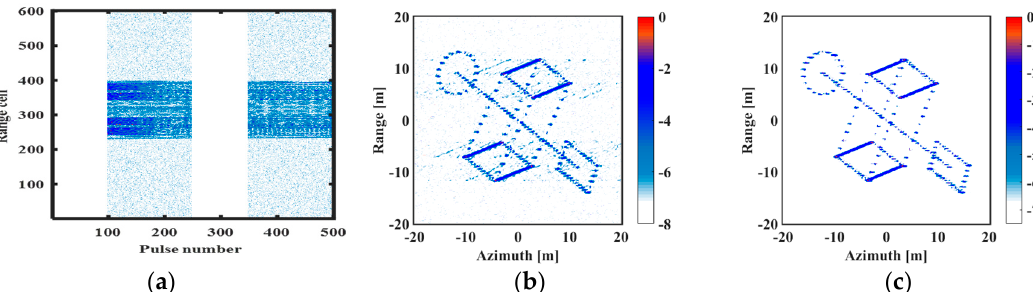
Figure 8. Range profiles and imaging results with GMS of 300 pulses: ( a ) Range profiles; ( b ) Imaging result of algorithm in [23]; ( c ) Imaging result of the proposed algorithm.